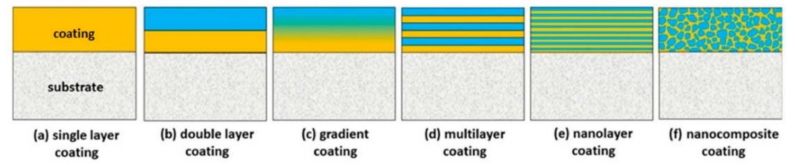
Figure 16. Scheme of how different types of coatings look when applied on the substrate [123].